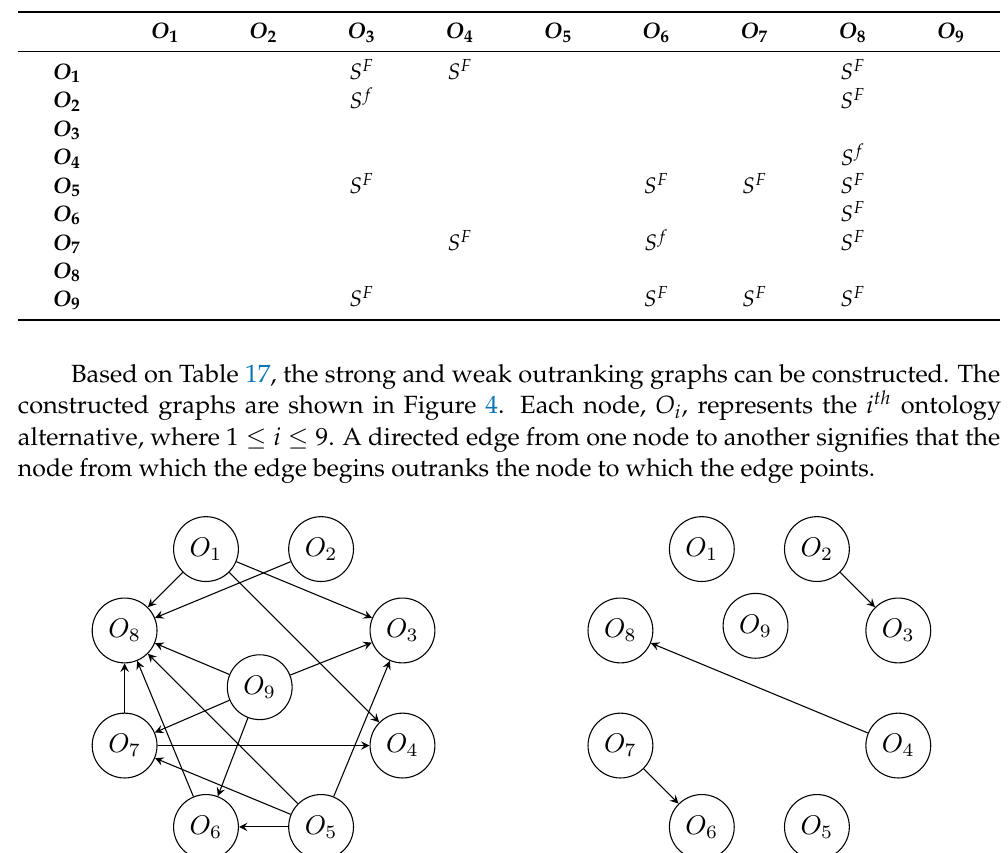
. ( b ) Weak outranking 1